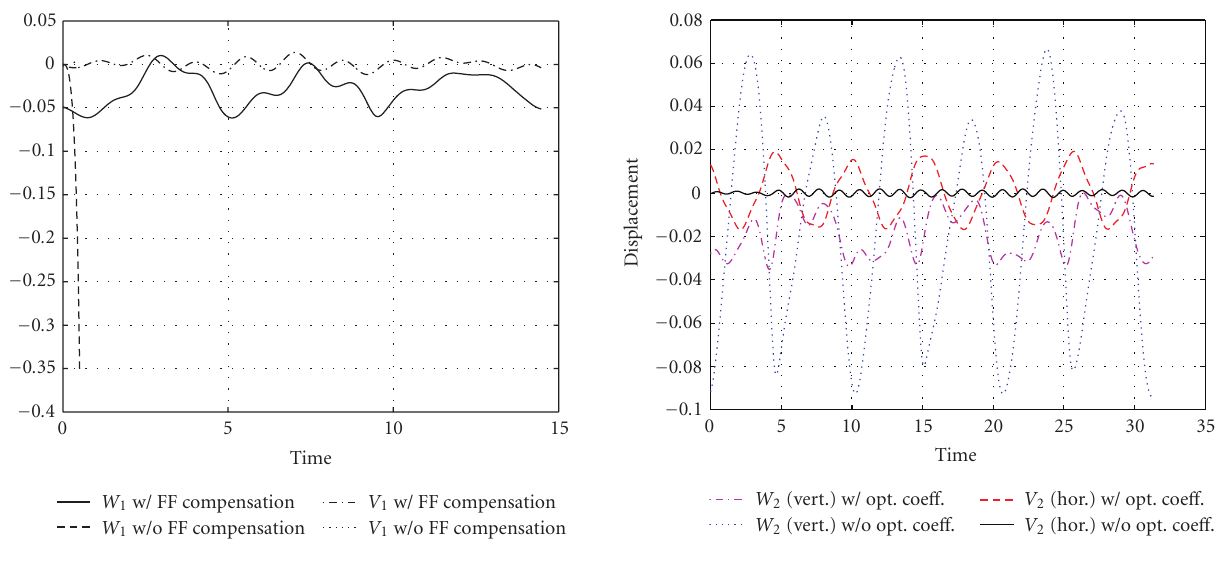
Figure 7: Response plots at Ω b = 0 . 6, bearing 2.